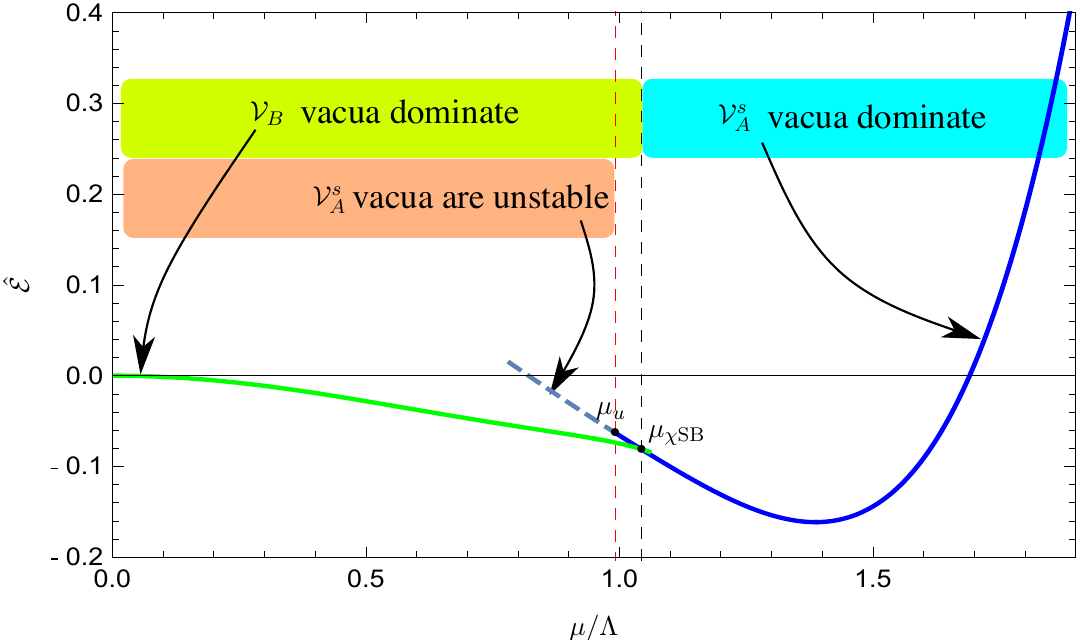
Figure 5 . Round S 3 vacua of the warped deformed conifold with fluxes. The vertical dashed black line indicates the first-order transition between the chirally symmetric (solid green curve) vacua with the spontaneously broken symmetry, see (5.3). The vertical dashed red line indicates the onset of the perturbative chiral symmetry breaking instability of the (which are denoted with the grey dashed curve), see